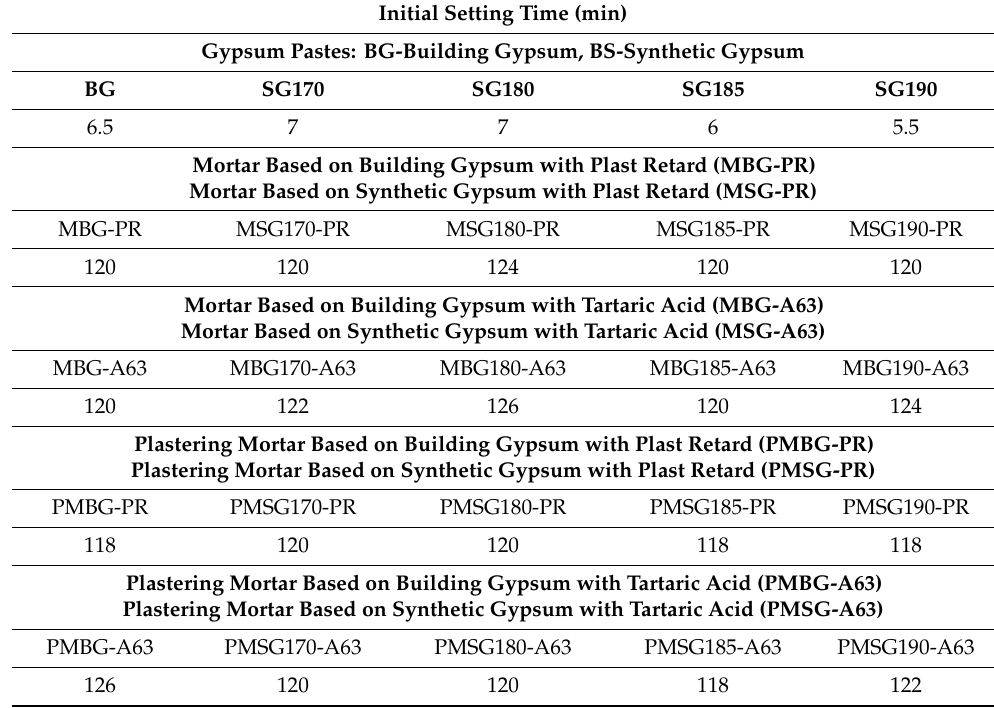
Table 8. Comparison of the initial values of the setting times t s of the gypsum pastes and masonry and plastering mortars based on synthetic gypsum with Plast Retard and tartaric acid. Initial Setting Time (min)